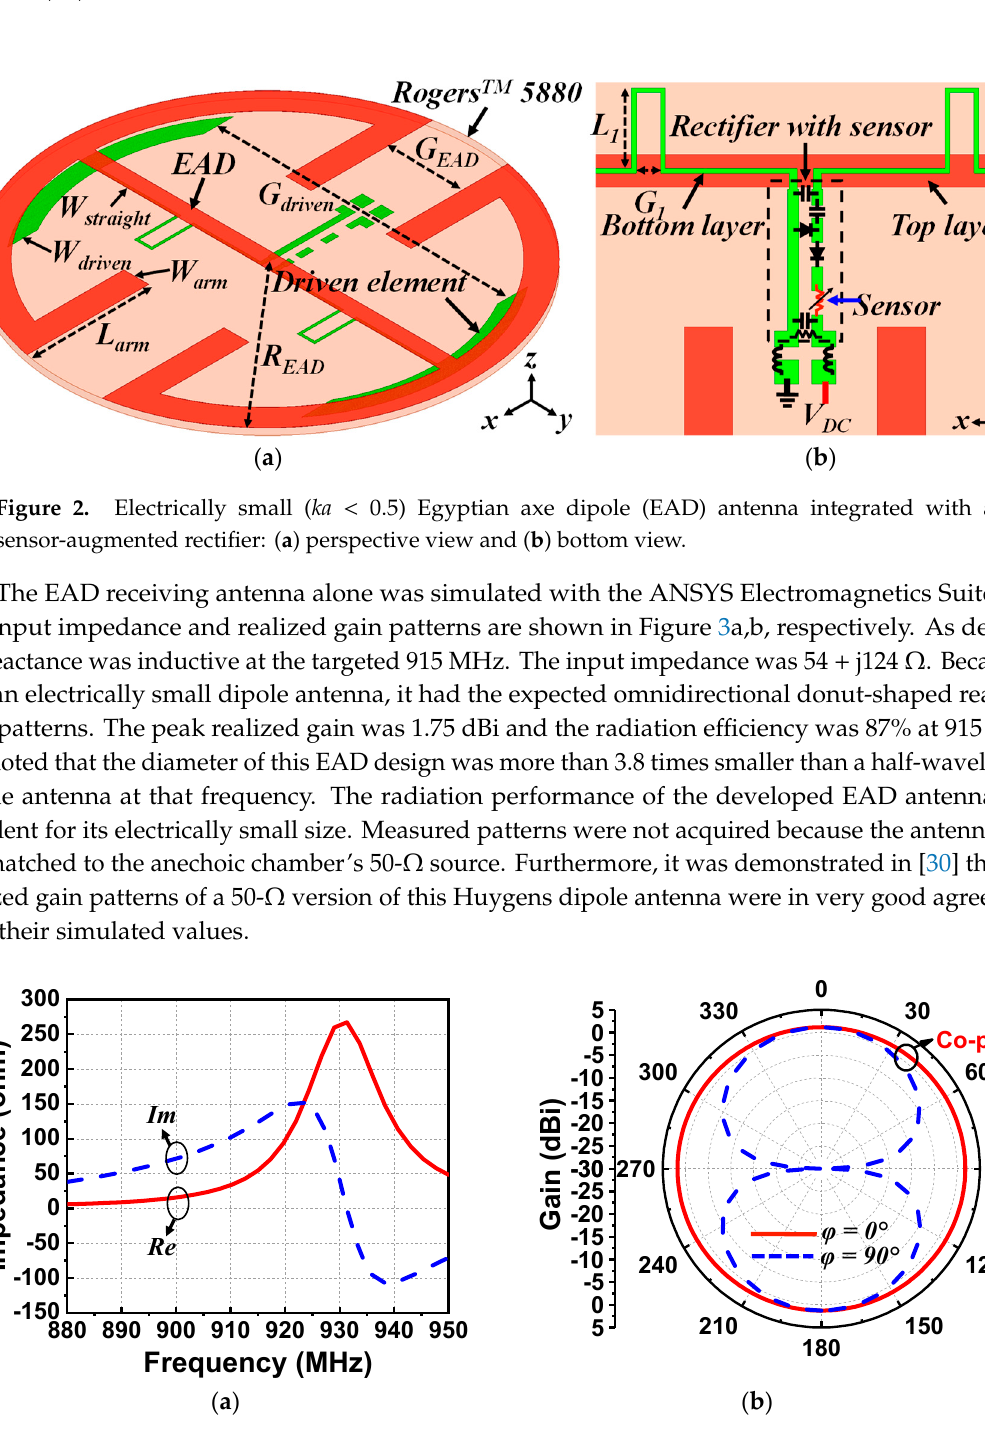
Figure 3. Simulated results of the EAD receiving antenna: ( a ) impedance and ( b ) gain patterns.